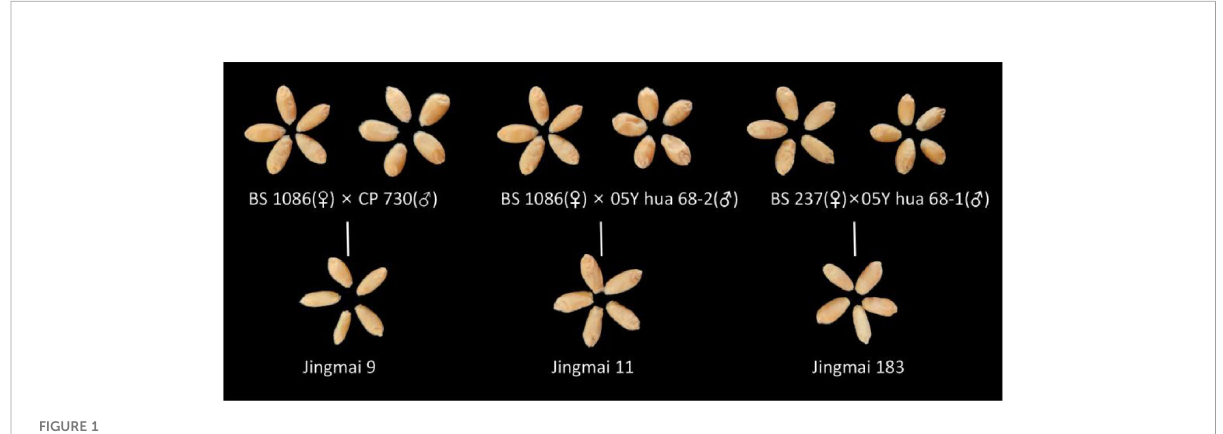
FIGURE 1 Images of wheat seeds and their